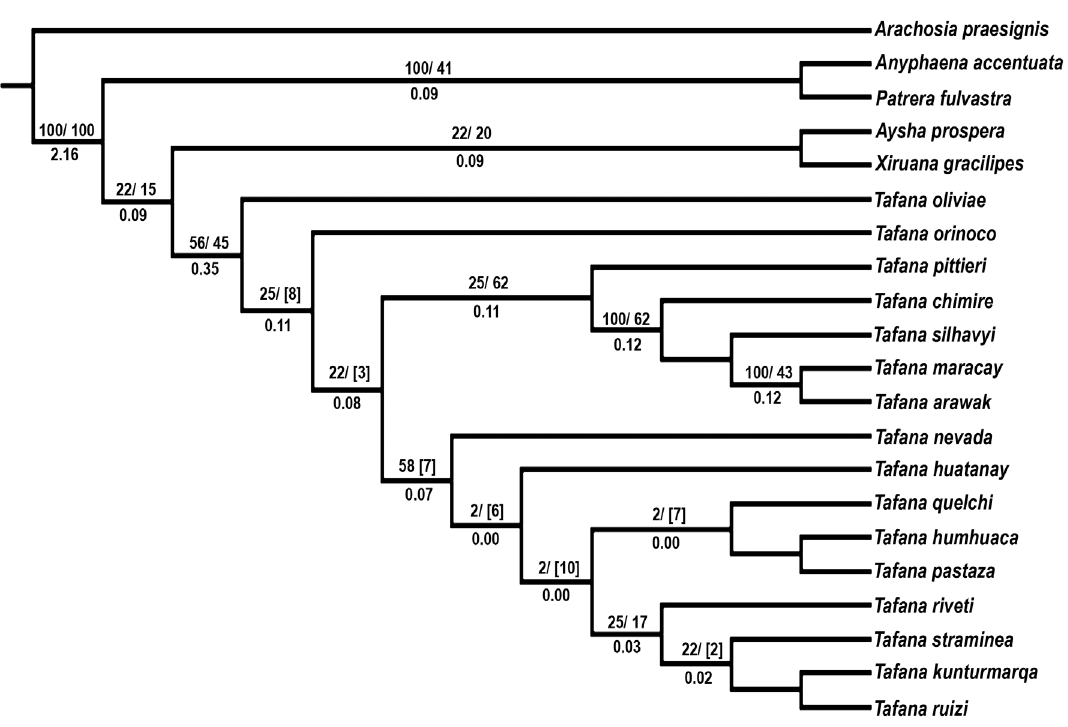
Fig. 3. Topology obtained under k = 7 (CI = 0.46, RI = 0.60, Fit = 27.319). Numbers above branches are relative Goodman-Bremer values (left) and Symmetric resampling values (right). Numbers below branches are Goodman-Bremer support values.